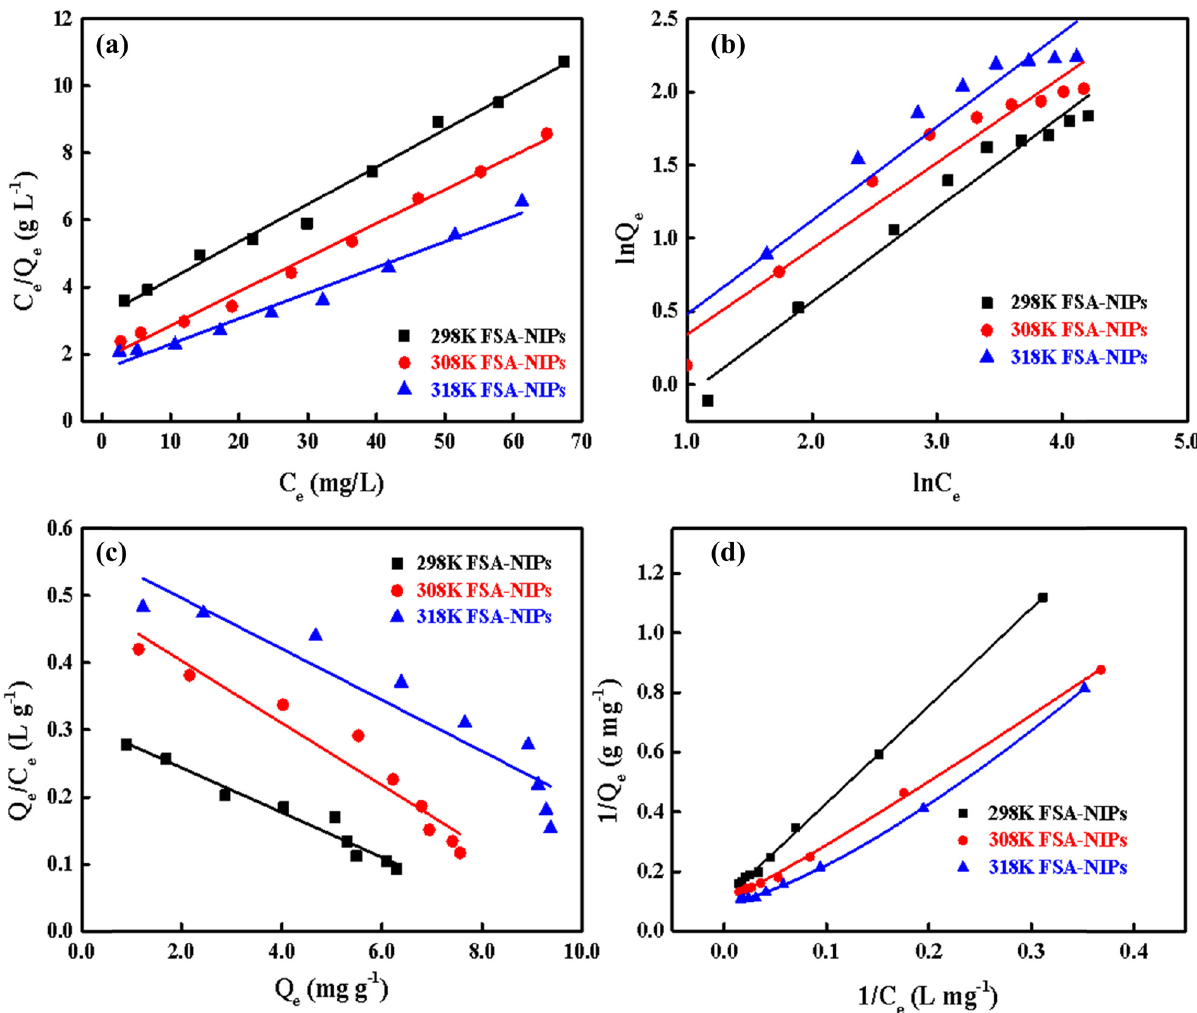
Figure A6: The linear fi tting curves of ( a ) Langmuir adsorption model, ( b ) Freundlich adsorption model, ( c ) scatchard adsorption model, and ( d ) slips or Langmuir – Freundlich model of 4 - MMC onto FSA - NIPs at di ff erent